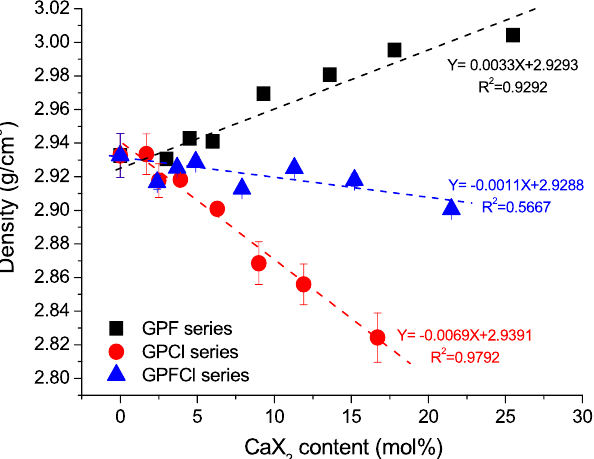
Figure 3. Glass density profiled as a function of CaX 2 (X = F/Cl/F + Cl) content. Linear relationships (Y = 0.0033x + 2.9293, R 2 = 0.9292 and Y = − 0.0069x + 2.9391, R 2 = 0.9792) between density and CaX 2 content are shown in GPF and GPCl glass series. Note that the line crossing the density values for the GPFCl series is applied to illustrate the general trend of the data.